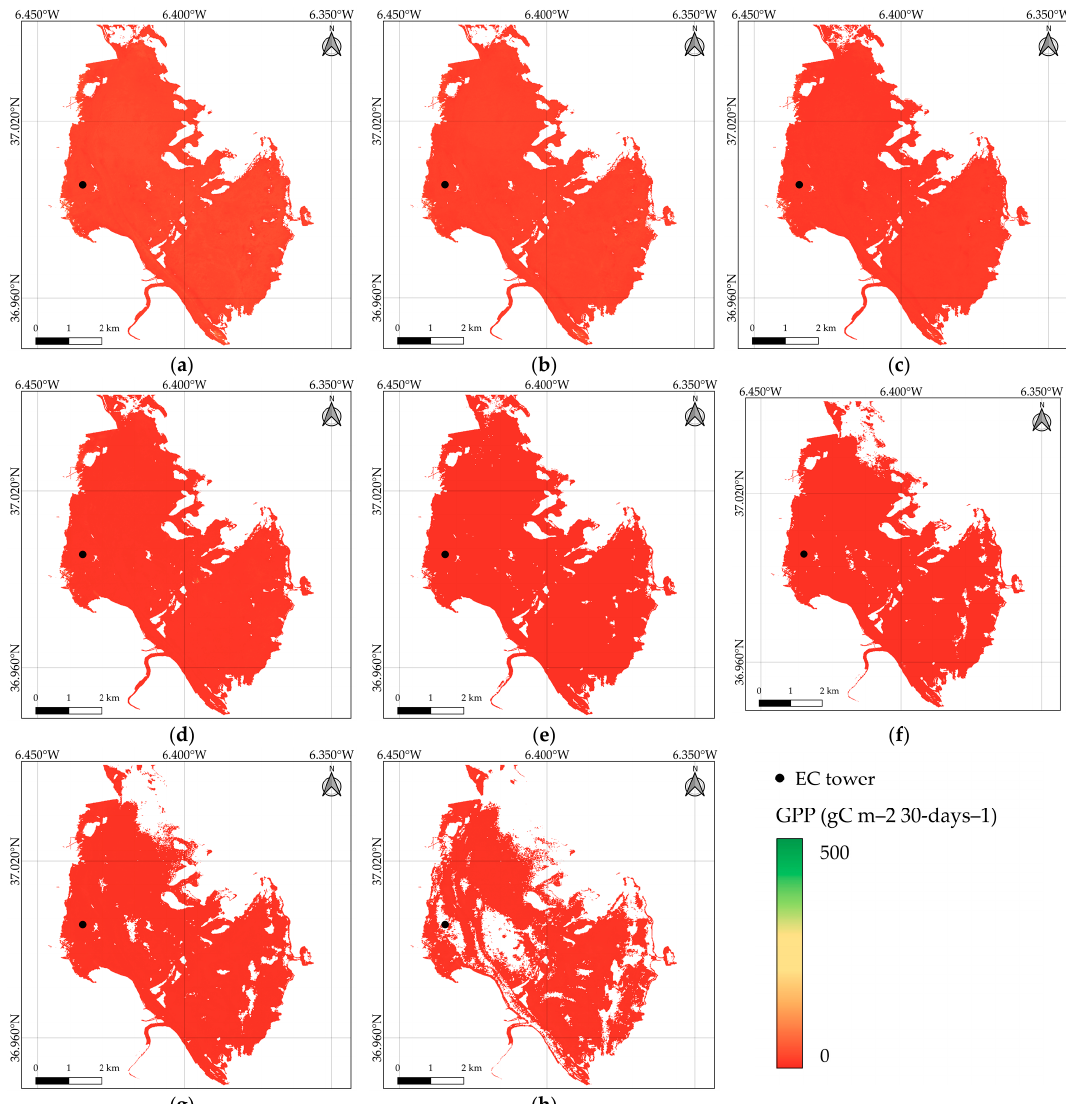
Figure 14. 15-days GPP maps. The maps show the spatial and temporal pattern of GPP (gC m − 2 15-days − 1 ). ( a ) 1–15 October 2020, ( b ) 16–31 October 2020, ( c ) 1–15 November 2020, ( d ) 16–30 November